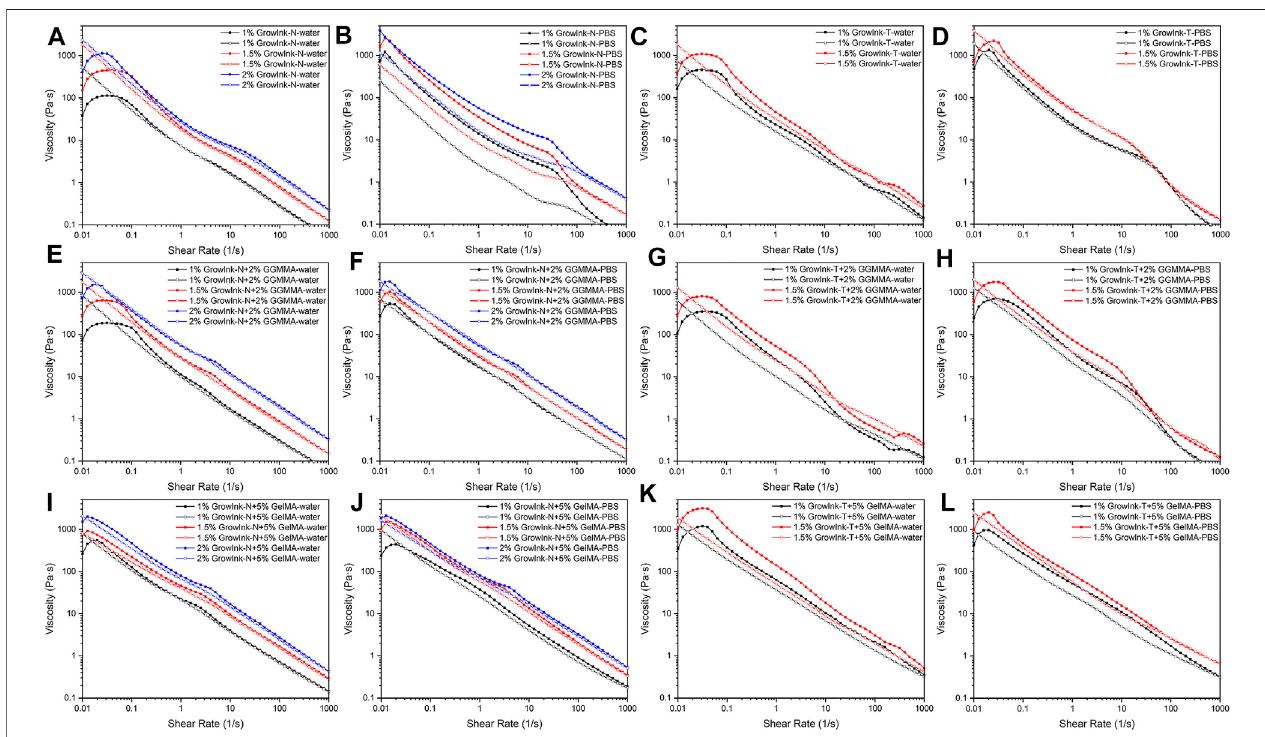
FIGURE 2 | Flow curves of formulated inks as a function of the shear rate [ (A – D) GrowInk-N and GrowInk-T, (E – H) GGMMA incorporated GrowInk-N – and GrowInk-T – basedinks,and (I – L) GelMAincorporatedGrowInk-N – andGrowInk-T – basedinksdilutedwithPBSbufferandwater,respectively.Closedsymbol:ramp-up and open symbol: